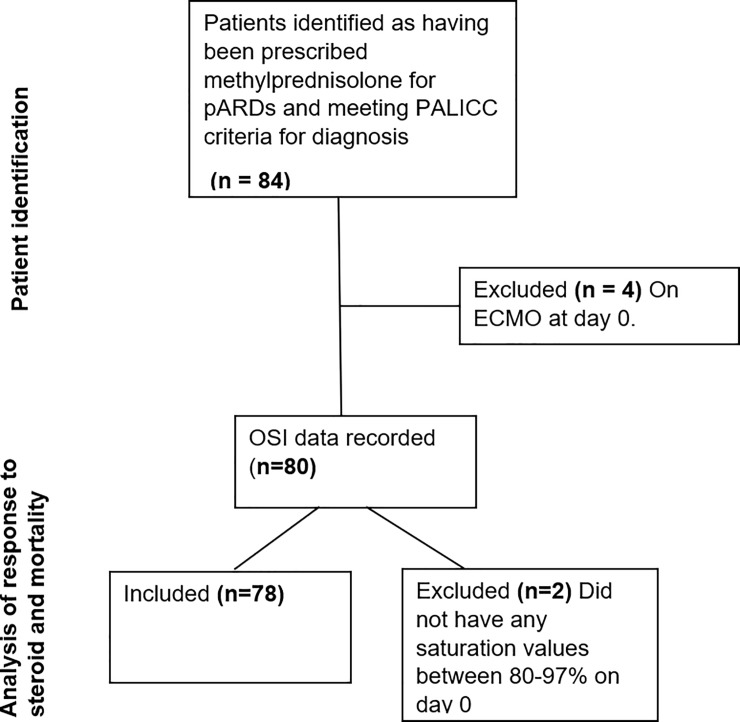
Patient selection and inclusion.